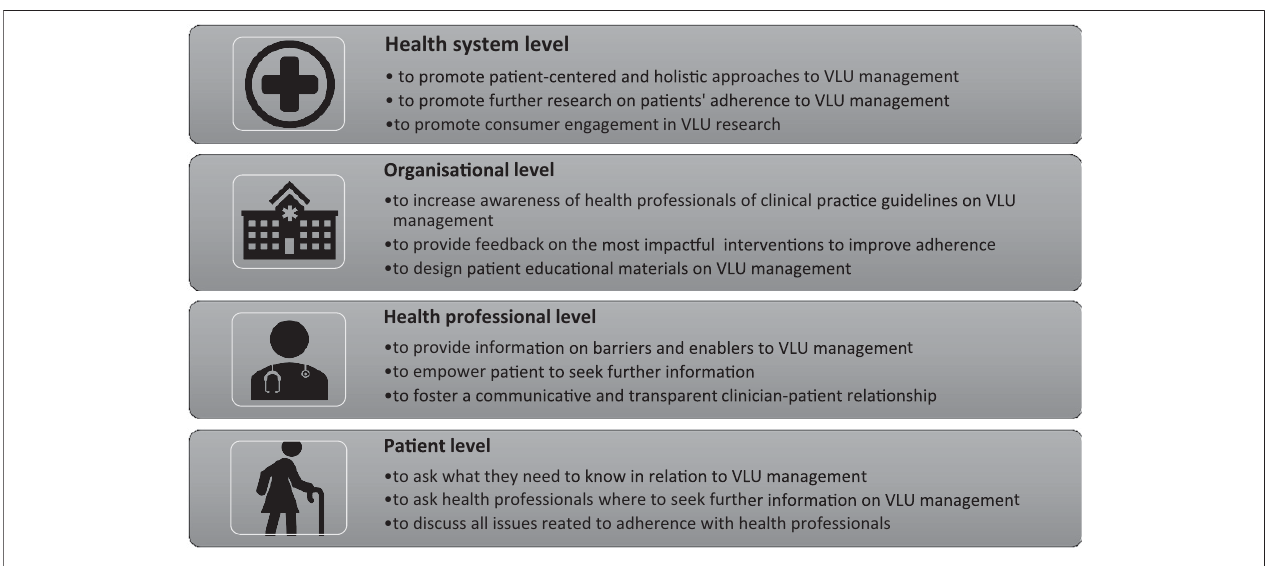
FIGURE 4 | Strategies to improve adherence to the venous leg ulcer treatment